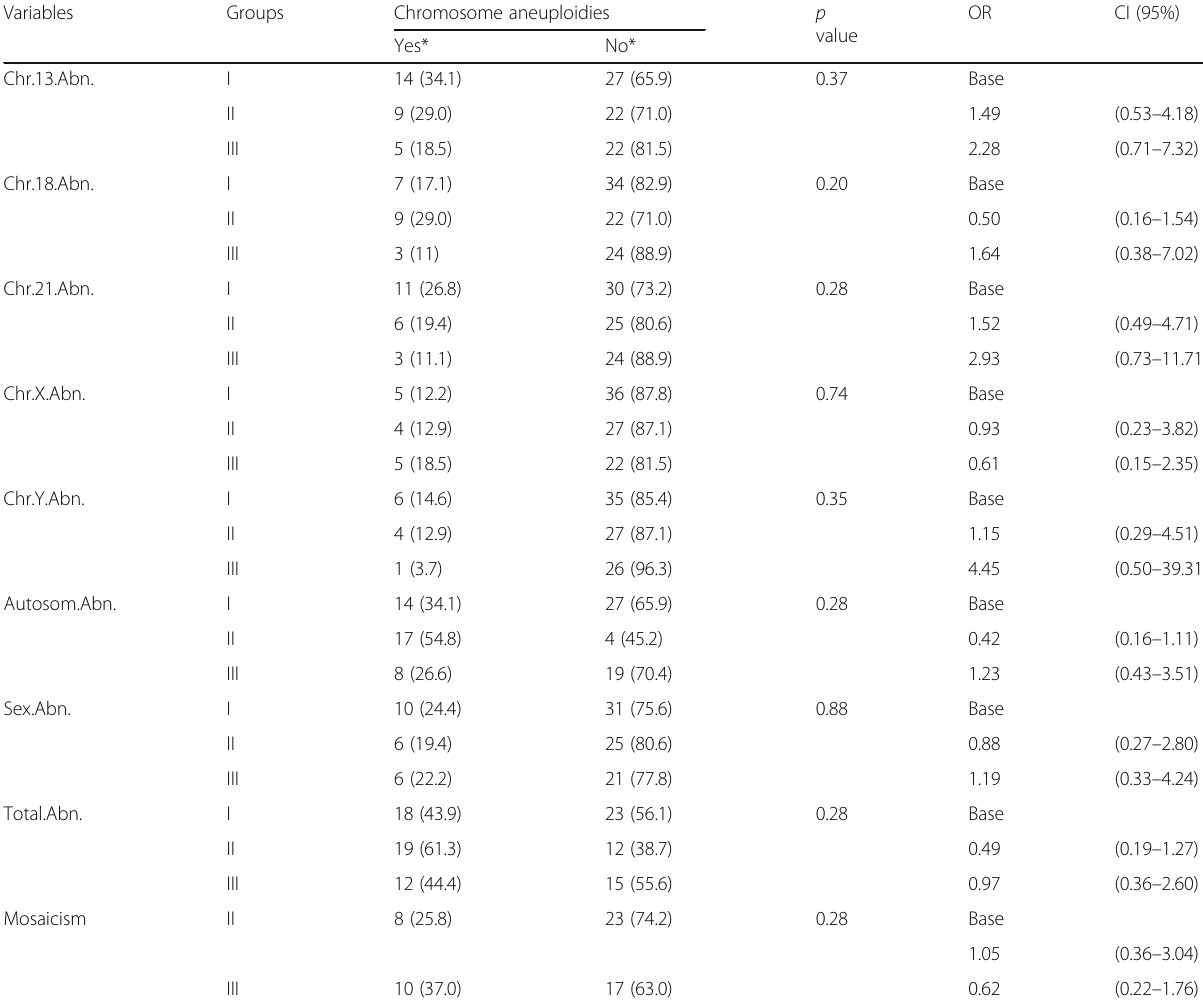
Table 1 Comparison the results of fluorescence in situ hybridization between groups Variables Groups Chromosome aneuploidies p Chr.13.Abn.